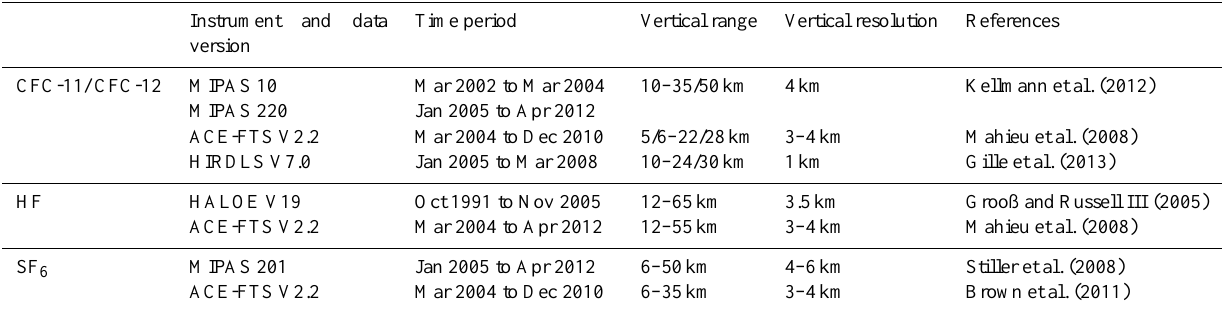
Table 2. Data version, time period, vertical range and resolution, and validation references for the CFC-11, CFC-12, HF, and SF 6 data sets included in this